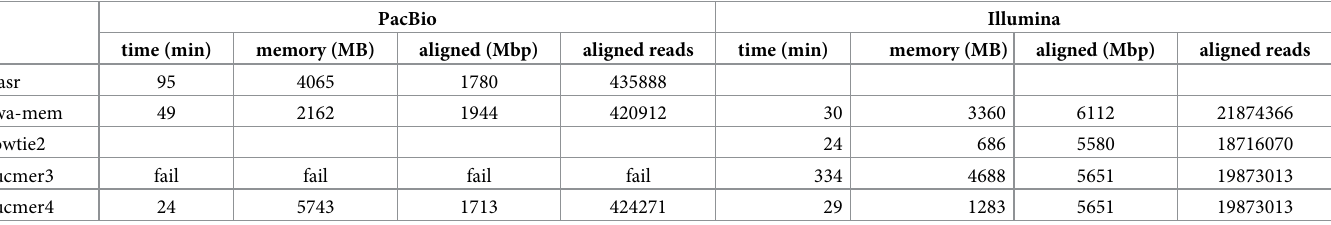
Table 4. Timing and memory usage to align PacBio and Illumina reads to the Arabidopsisthaliana reference genome. Timings reported here include the time used to build the genome index. The alignments reported by nucmer3 and nucmer4 for the Illumina data were identical. Nucmer3 experienced a reproducible crash when aligning PacBio reads to the A. thaliana reference.